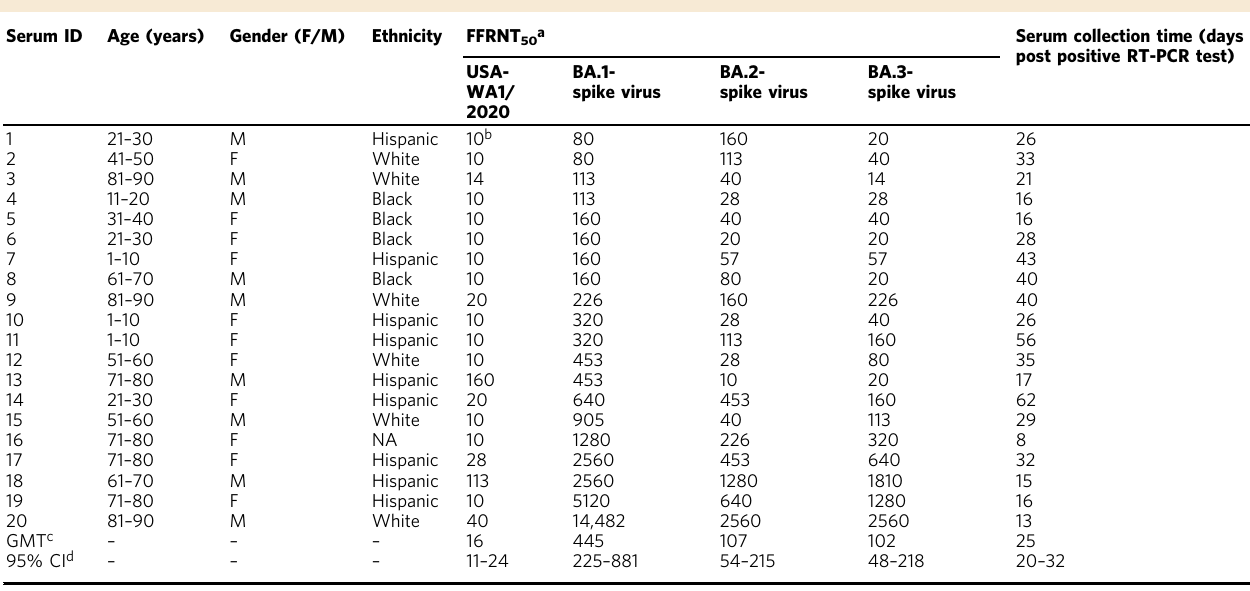
NA not available. a Individual FFRNT 50 value is the geometric mean of duplicate FFRNT results. b FFRNT 50 of <20 was treated as 10 for plot purpose and statistical analysis.